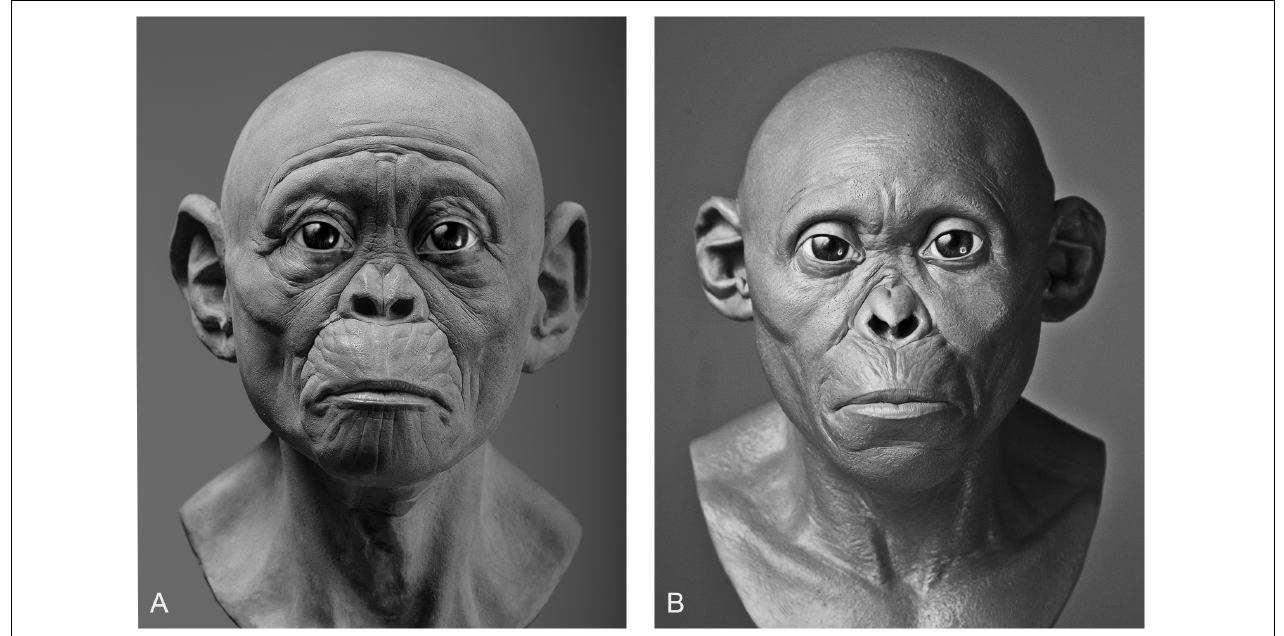
FIGURE 3 | Two facial reconstructions of the Taung child (without hair and pigment) that were produced one year apart. Please note how variability between these reconstructions is exemplified by the subjective decision to depict the subject as more apelike (A) or more humanlike (B) .